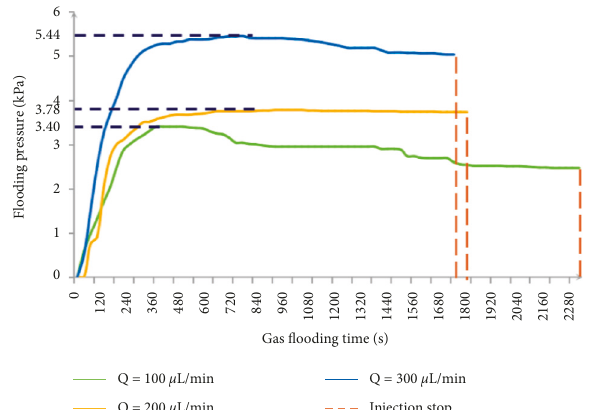
Figure 8: The continuous gas injection time-flooding pressure curve at diverse gas injection rate.